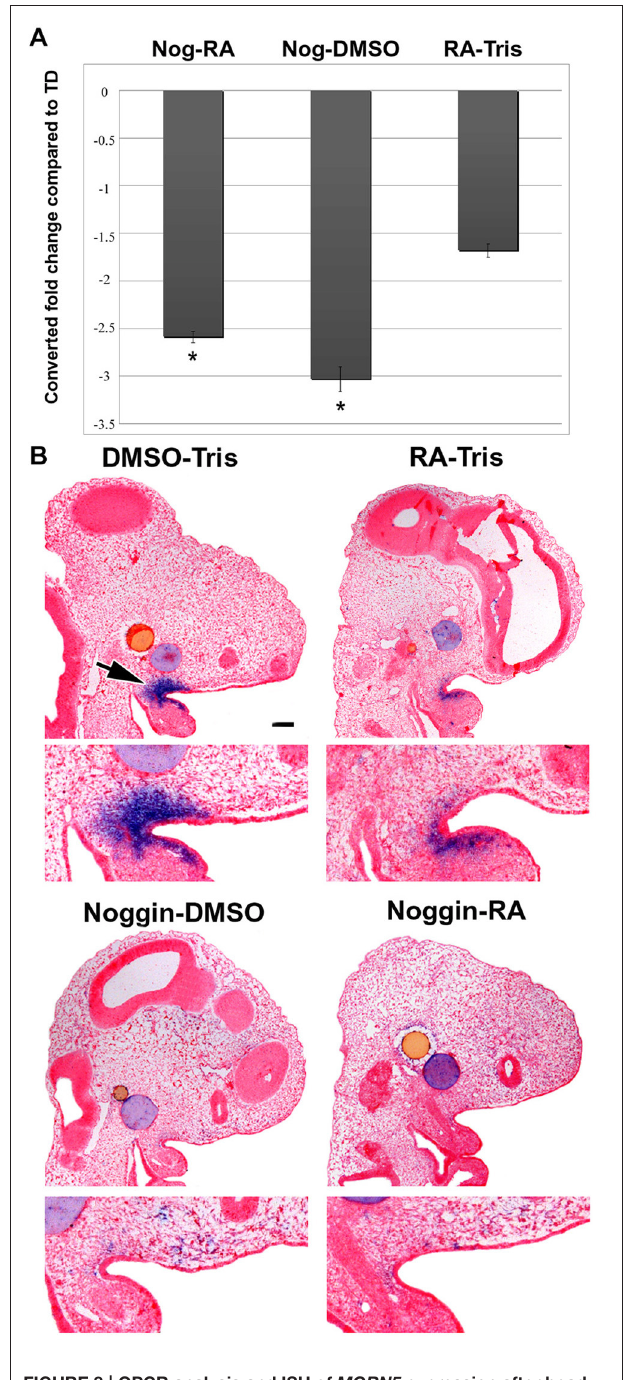
FIGURE 8 | QPCR analysis and ISH of MORN5 expression after bead implantation. (A) QPCR analysis showed 1.68 times downregulation after RA-Tris, 3.03 after Noggin-DMSO and 2.59 after Noggin-RA treatment in comparison to control DMSO-Tris. (B) Control embryos implanted with beads soaked in DMSO-Tris had strong expression in maxillary region and maxilla-mandibular cleft. In RA-Tris treated embryos was very weak MORN5 expression. After Noggin-DMSO treatment, expression was rapidly decreased. No expression of MORN5 was observed after Noggin-RA treatment. Nog, Noggin; RA, Retinoic acid; TD, Tris-DMSO. Scale bars = 100 µ m. t -test; * p <